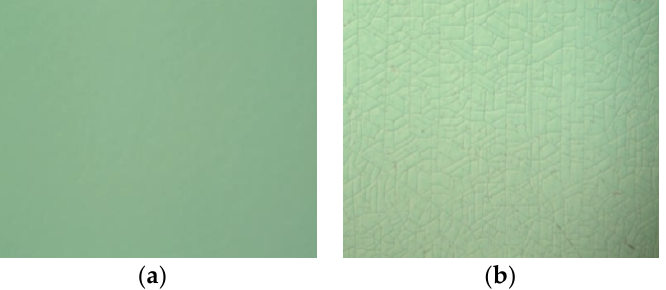
Figure 2. Optical microscopy images (1 mm × 1 mm) of GaN grown on Si substrate ( a ) with and ( b ) without the two-step growth method.